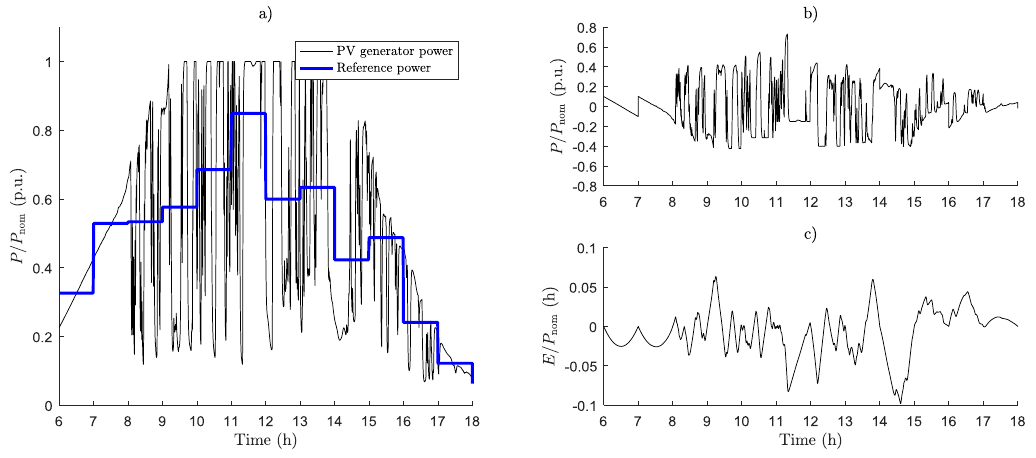
Figure 8. ( a ) 10 MW PV generator power and the grid feeding reference power; ( b ) the corresponding power taken from the ESS and ( c ) the energy stored in ESS (state of charge) with 60 min ISP on 17th of June 2015.